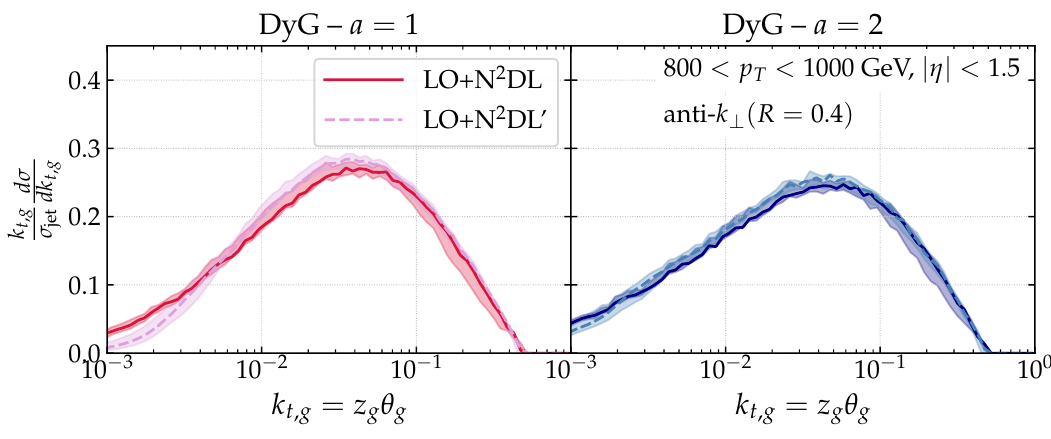
Figure 2 . The k t,g -distribution with a minimal N 2 DL resummation (see eq. (2.53) and table 1), and including sub-leading contributions N 2 DL’ (see eq. (2.54) and appendix A). Both curves are normalized to σ 0 + σ 1